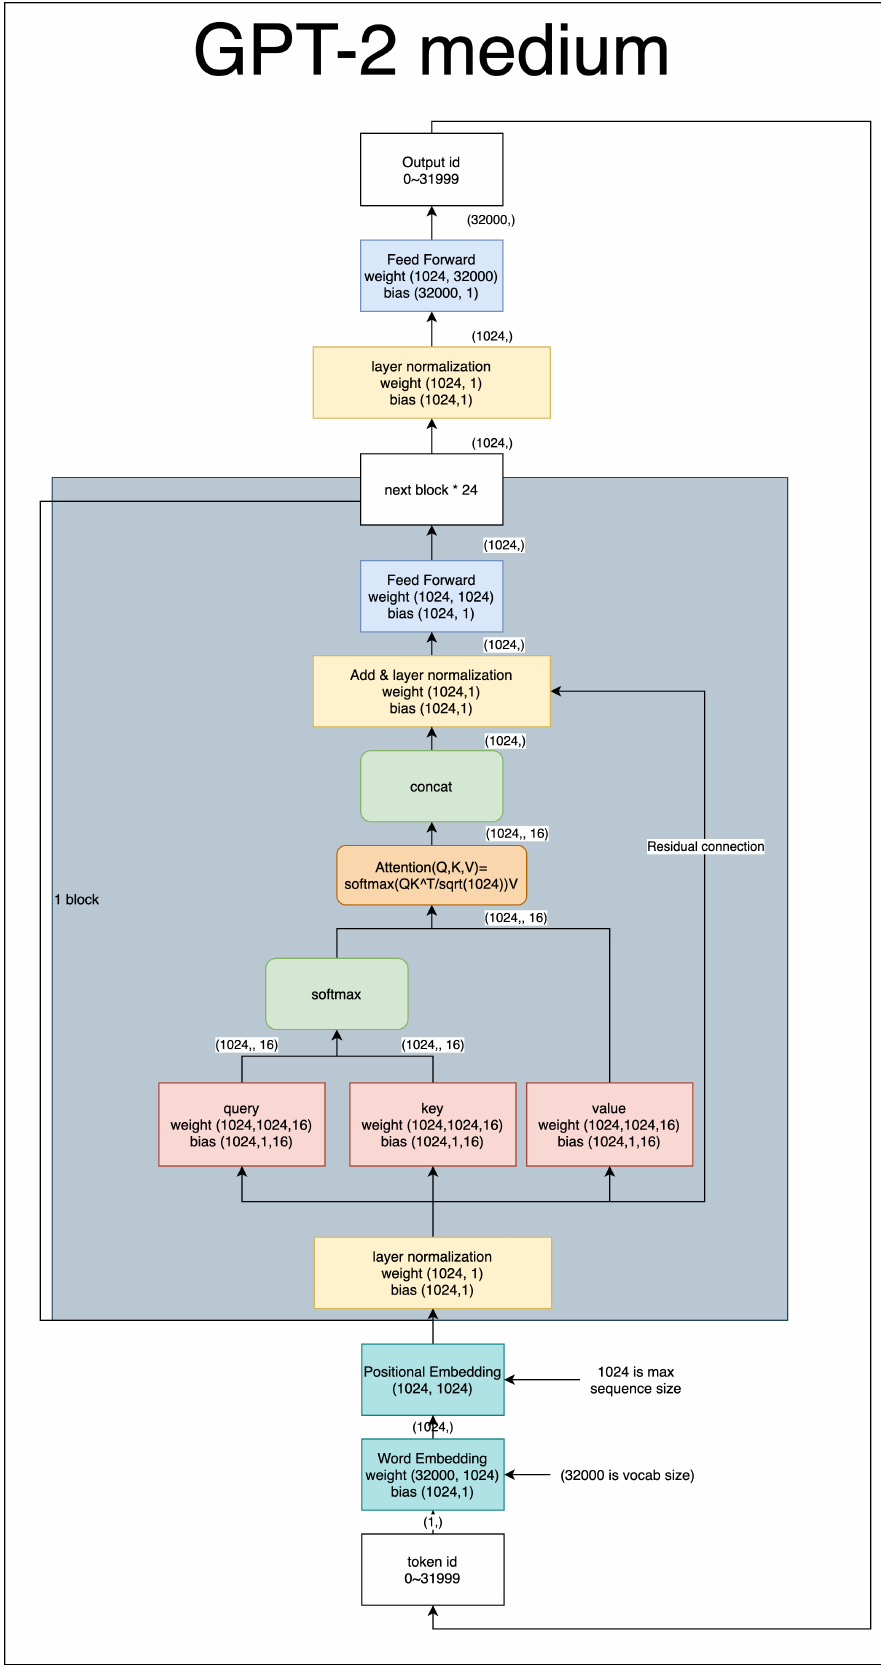
Figure 5. In the GPT-2 normal model, where the numbers next to the weight and bias indicate the size of the tensor, and the numbers with arrows indicate the size of the tensor flowing through